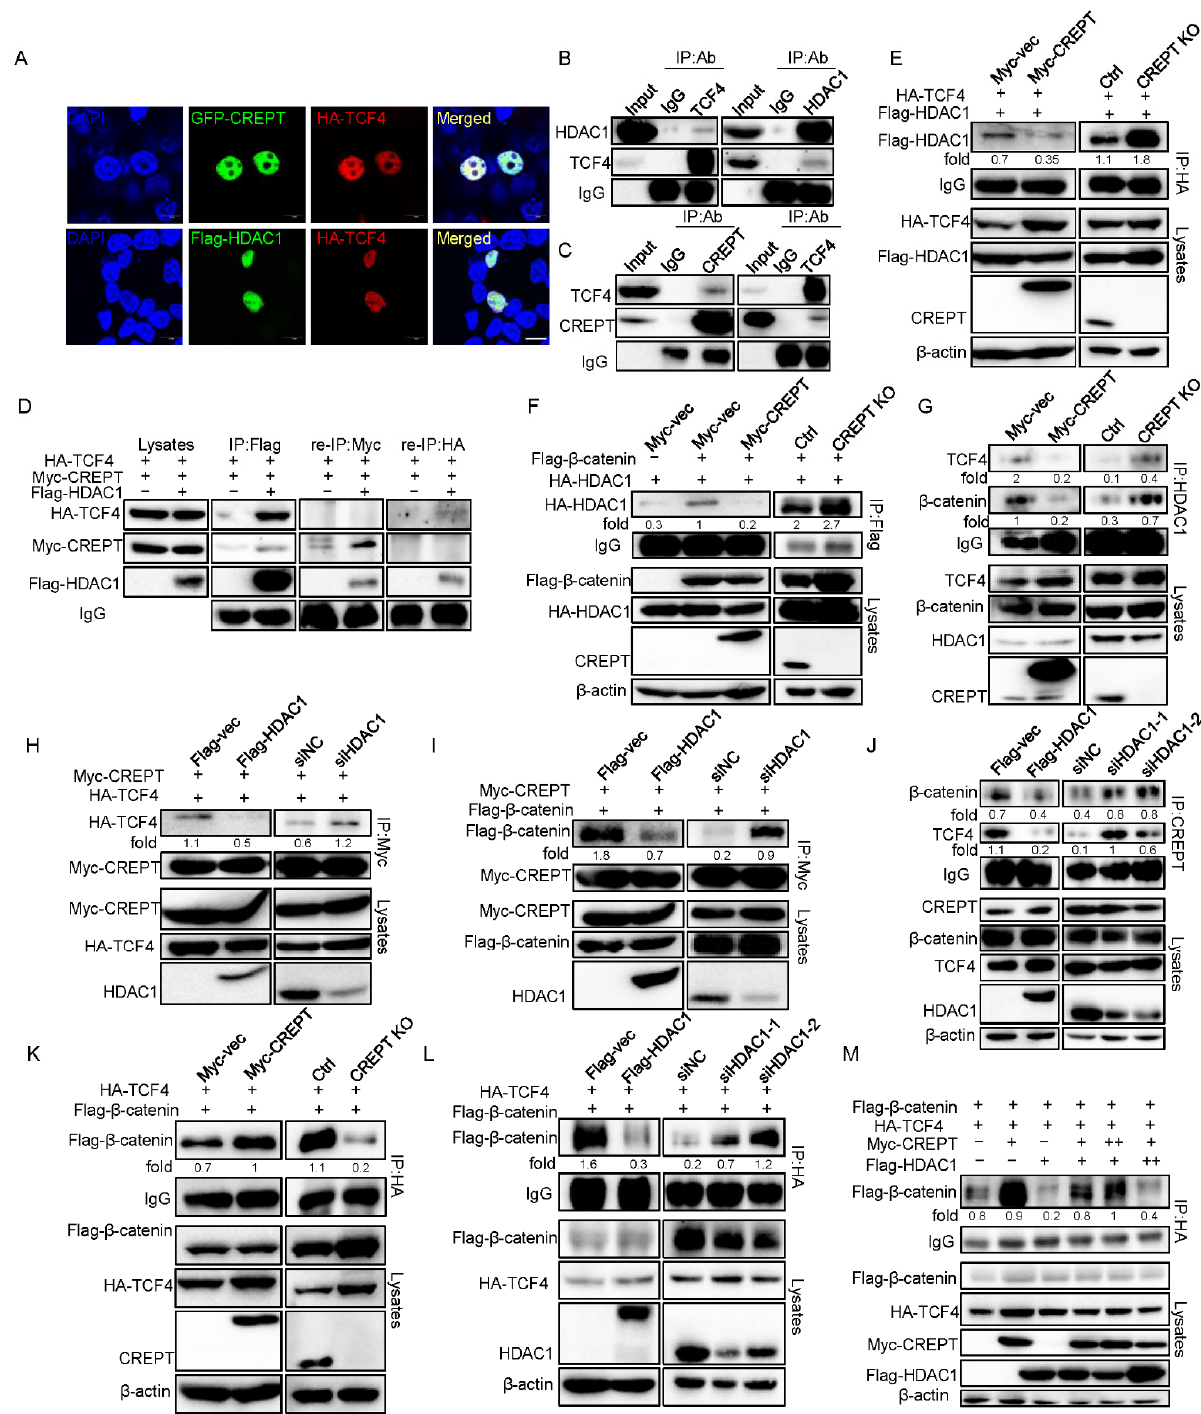
Figure 4. HDAC1 and CREPT exclusively interact with TCF4 and β -catenin. ( A ). HDAC1 and CREPT co-localize with TCF4 in the nucleus. HEK293T cells expressing HA–TCF4 together with GFP–CREPT or Flag–HDAC1 were scanned by confocal microscope. Scale bar, 10 um. ( B ). The interaction of HDAC1 with TCF4 is shown. Nuclear extracts from HEK293T cells were used. ( C ). CREPT associates with TCF4. Immunoprecipitation was performed with indicated antibodies. ( D ). TCF4 interacts with CREPT and HDAC1 exclusively. HEK293T cells were co-transfected with Flag–HDAC1 (10 µ g), HA–TCF4 (6 µ g) and Myc–CREPT (4 µ g) for IP experiments using an antibody against Flag. Precipitants were used for re-IP experiments using an antibody against Myc or an antibody against HA. ( E ). CREPT